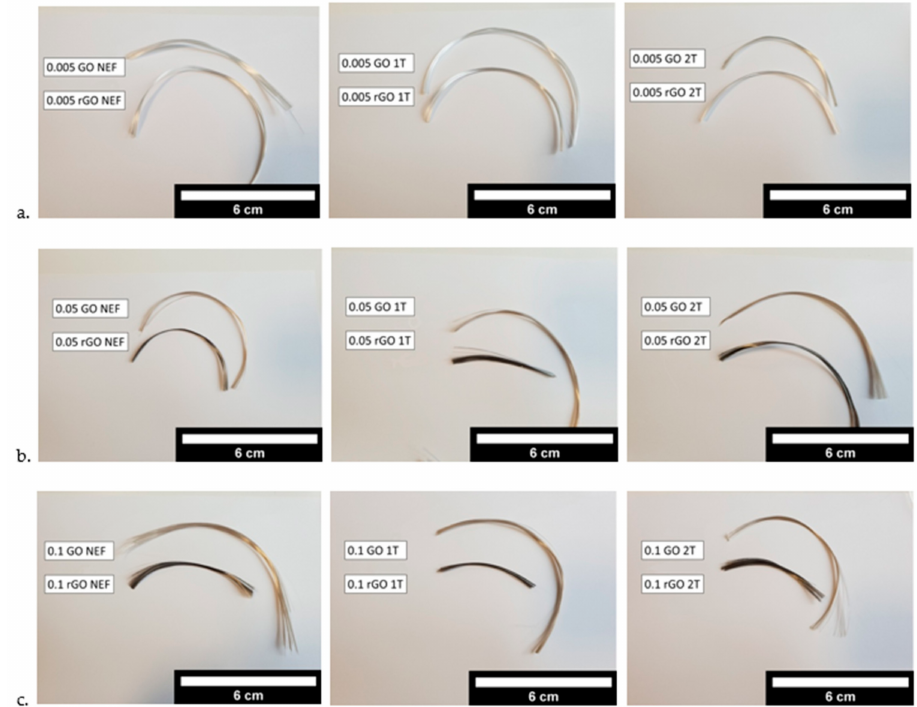
Figure 3. Representative images of ( a ) 0.005 GO/rGO, ( b ) 0.05 GO/rGO, ( c ) 0.1 GO/rGO fibers (NEF, 1T, 2T).